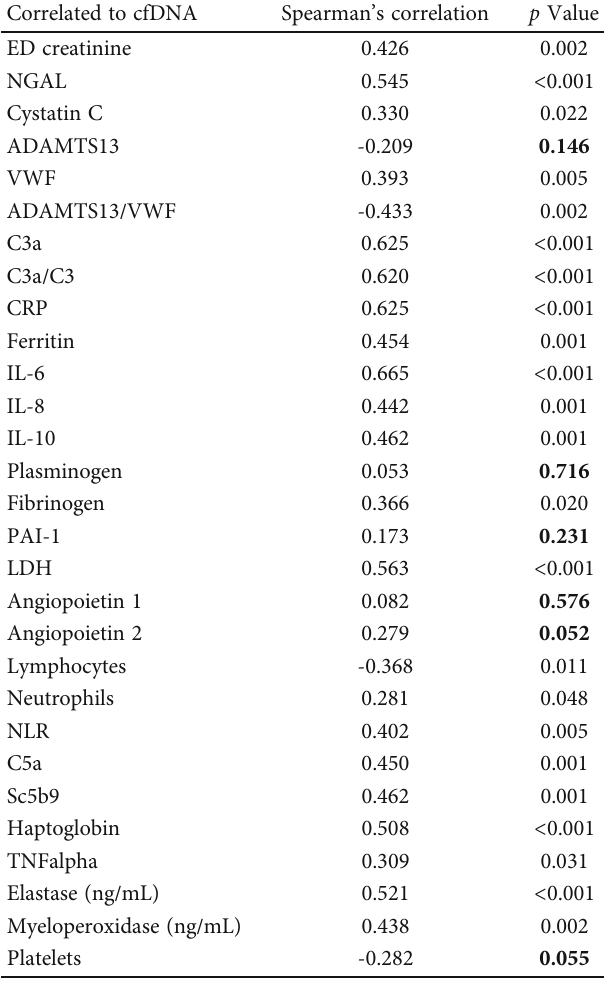
Table 3: Correlation between cell-free DNA (cfDNA) and markers of AKI, TMA, in fl ammation, and NETs components.